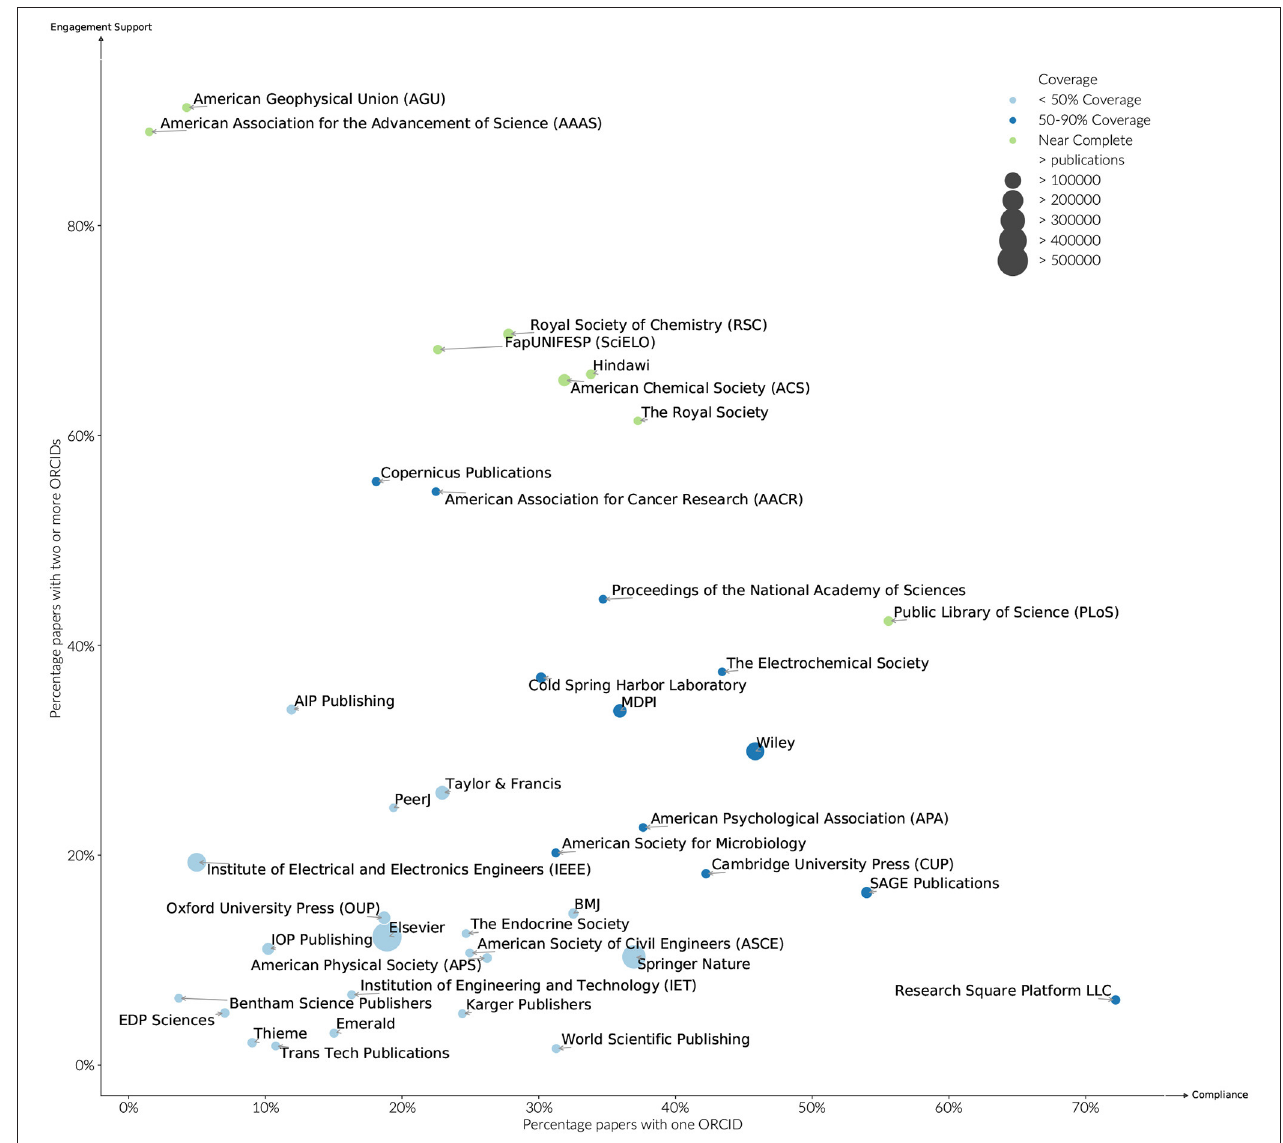
FIGURE 9 | ORCID adoption and engagement by publisher, publications